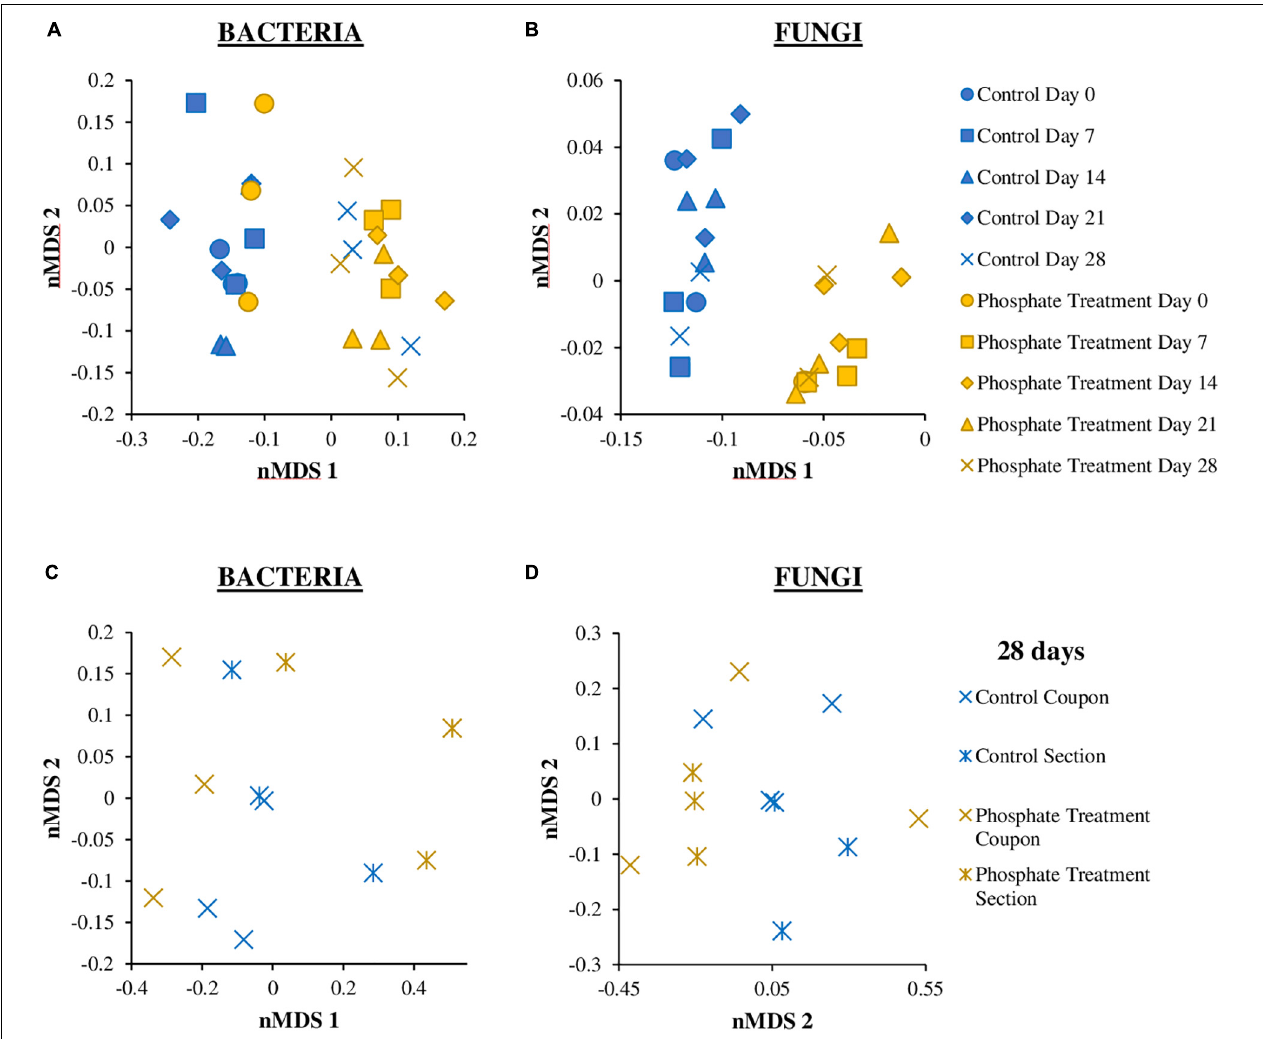
FIGURE 6 | Non-metric multidimensional scaling (nMDS) plot based on the bacterial (A,C) and fungal (B,D) relative abundance of biofilm coupons (A,B) and section (C,D) samples. The analysis was based on Bray–Curtis similarity matrix calculated from the relative abundance of bacteria and fungi OTUs at 97% cut off. The different groups are clustering according to the treatment used (Phosphate treatment and Control) and the time sampling (0, 7, 14, 21, 28